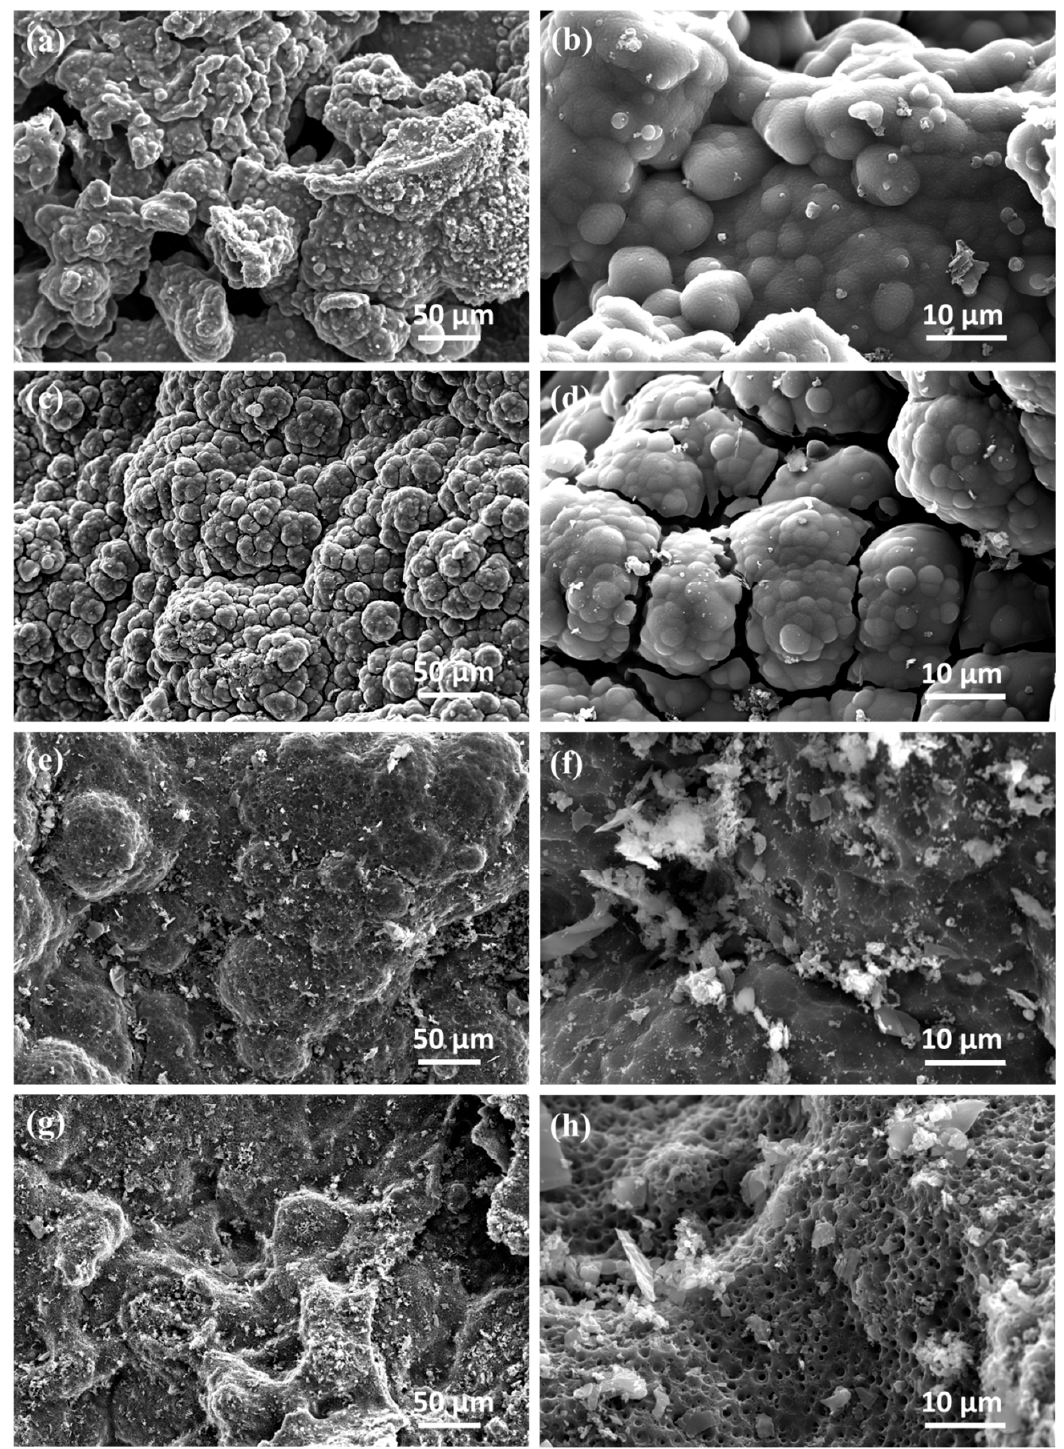
Figure 3. SEM images of each carbonaceous deposit layer in the coking chamber: sample #1 carbonaceous deposit layer, ( a,b ); sample #2 carbonaceous deposit layer, ( c,d ); sample #3 carbonaceous deposit layer, ( e,f ); and sample #4 carbonaceous deposit layer, ( g,h ).